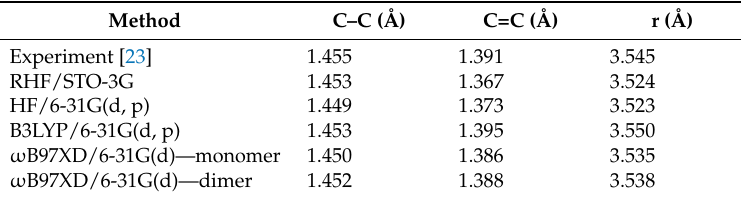
Table 2. Several density functional theory (DFT) methods have been assessed by evaluating the optimized structural parameters of the C60